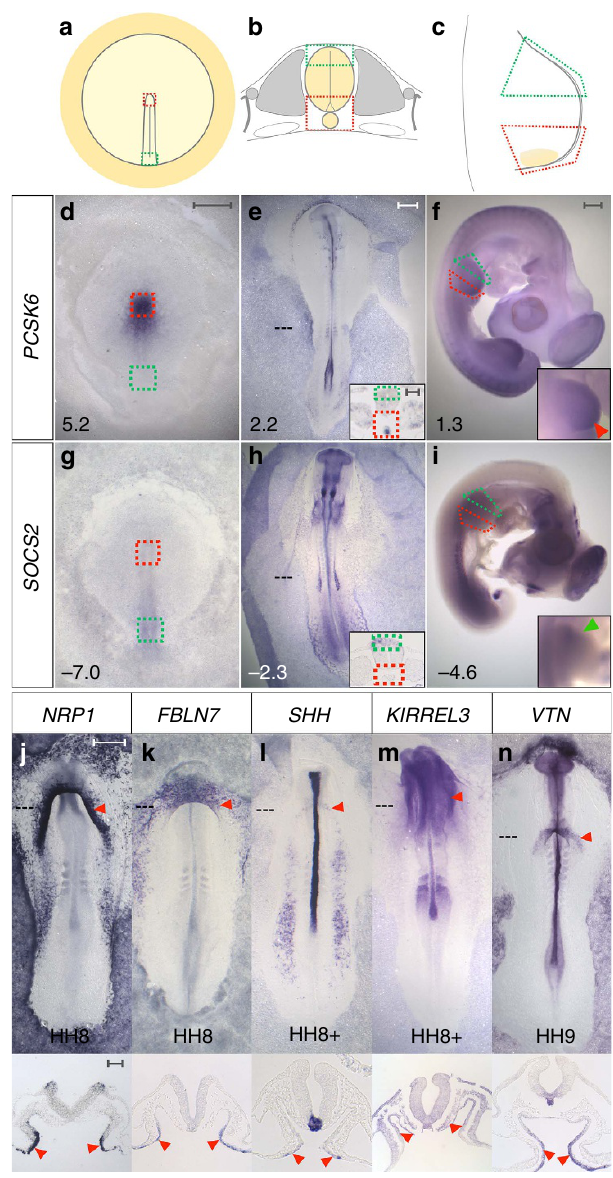
Figure 1 | Transcriptome comparison of known organizers reveals genes co-expressed in organizers and in the Anterior Intestinal Portal endoderm. ( a – c ) Experimental design. ( a ) Hensen’s node (red box) was compared with posterior primitive streak (green box); ( b ) notochord and ventral neural tube (red box) was compared with dorsal neural tube (green box) and ( c ) posterior wing bud (red box) was compared with anterior wing bud (green box). ( d – i ) One gene enriched in organizers is PCSK6 ( d – f , red boxes, red arrowhead in f -inset) and SOCS2 exemplifies a depleted gene ( g – i , green boxes, green arrowhead in i -inset). Fold-change values are indicated. ( j – n ) Examples of organizer-enriched transcripts expressed in the anterior intestinal portal endoderm (AIP) (red arrowheads): NRP1 ( j ), FBLN7 ( k ), SHH ( l ), KIRREL3 ( m ) and VTN ( n ). Scale bars, 0.5mm in whole- mounts and 0.1mm in sections. NATURE COMMUNICATIONS|7:12656|DOI: